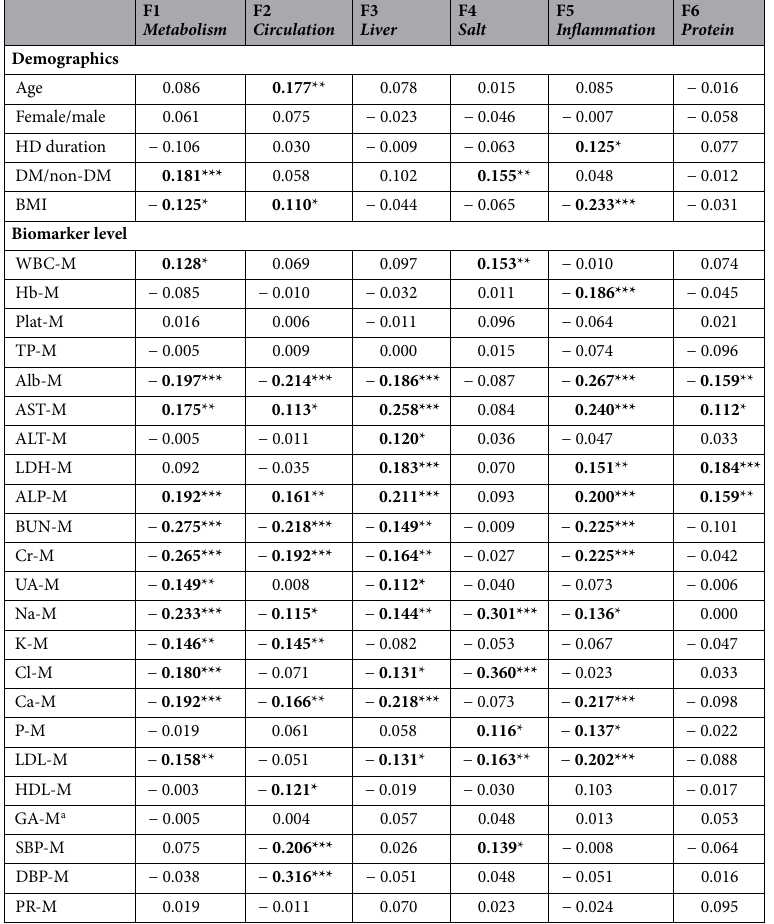
Table 3. Correlations between estimated factor scores and study variables. HD hemodialysis, DM diabetes mellitus, BMI body mass index. Coefficients printed in boldface indicate P < 0.05. For a GA-M, the coefficients were calculated for diabetic subjects only. Correlations between continuous variables were assessed by Pearson or Spearman correlation coefficients according to the distribution of the variables. For combinations involving dichotomous variables (gender and diabetes status), point biserial correlation coefficients are shown and the P -values are determined by Welch t-test. *** P < 0.001, ** P < 0.01, * P <